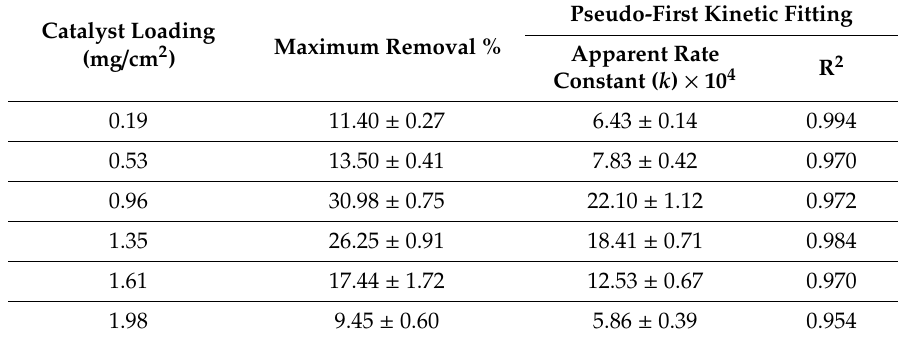
Figure 2. Effect of TiO 2 loading and residence time on TOC reduction in GW (interactive plot presented in Figure S3). Table 4. Maximum TOC removal (%) and apparent pseudo-first order rate constant as a function of TiO 2 catalyst loading.